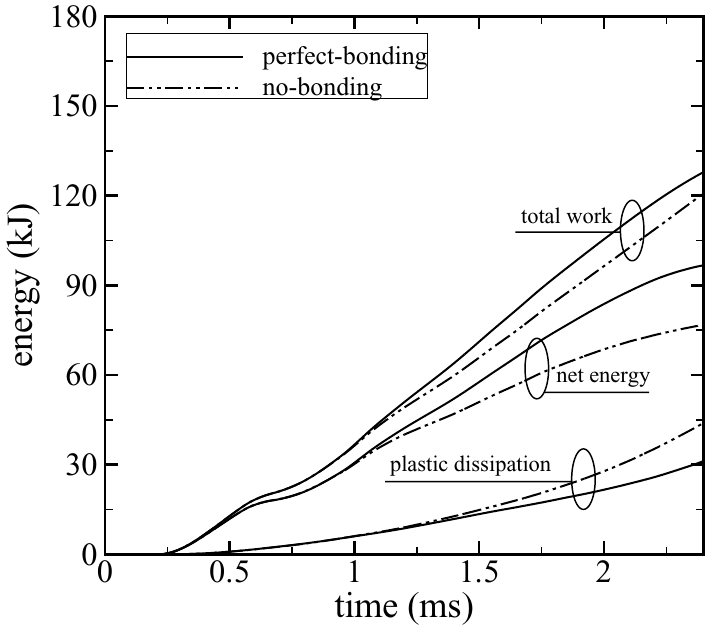
Fig. 10. Comparison of energy transfer time histories between the perfect- and no-bonding sandwich plates with clamped ends.